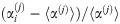
Distribution of the relative deviation on the power law exponents.
(αi(j)−〈α(j)〉)/〈α(j)〉, for all super-editors and time windows with adequate statistics, in the EN-WP.